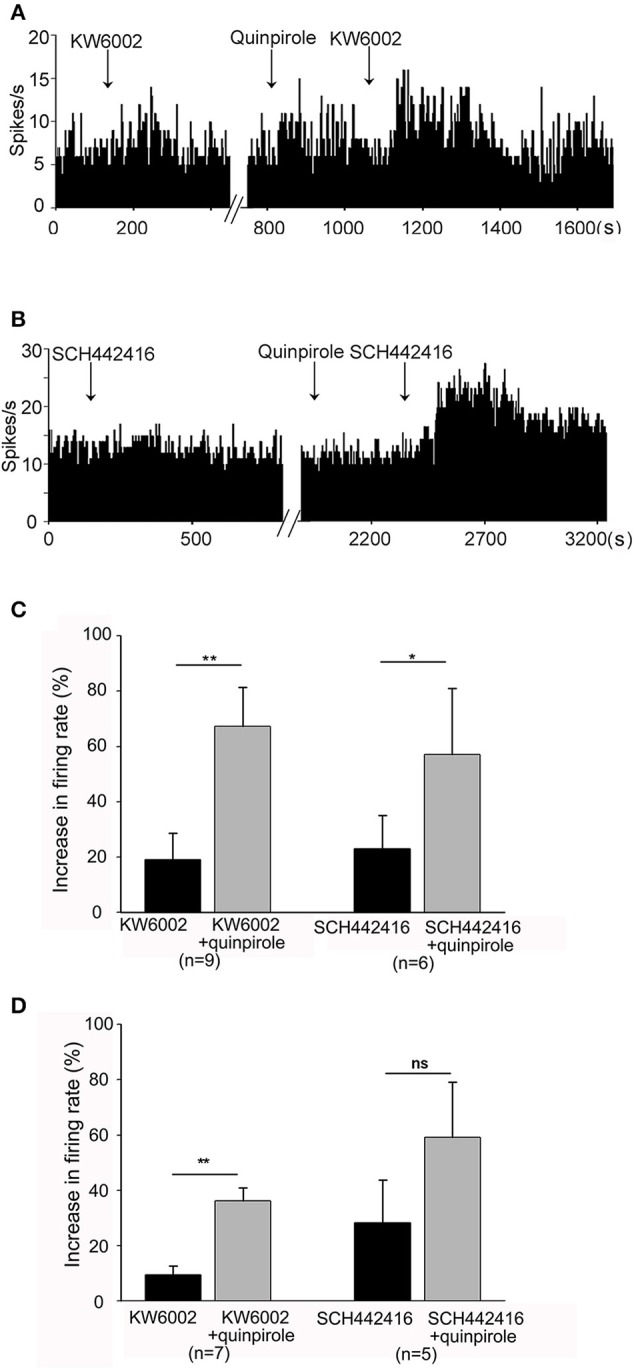
Quinpirole enhanced KW6002 and SCH44216-induced increase in firing rate of pallidal neurons. (A) The first time application of 1 μM KW6002 alone increased the pallidal firing rate by 48.86% in this neuron of normal rat. In the presence of 1 μM quinpirole, the second time application of KW6002 significantly increased the firing rate by 78.07% in this neuron. (B) Typical frequency histograms showing that quinpirole enhanced 1 μM SCH44216-induced excitation of firing rate in this neuron. (C) Pooled data summarizing the effects of quinpirole on KW6002 and SCH44216-induced increase of firing rate in normal rats. (D) Pooled data summarizing the effects of quinpirole on KW6002 and SCH44216-induced increase of firing rate in parkinsonian rats. The black bars represent the effects of KW6002 or SCH44216 alone, while the gray bars represent the effects of KW6002 or SCH44216 together with quinpirole. *P < 0.05, **P < 0.01, ns, not significant, paired-samples t-test.